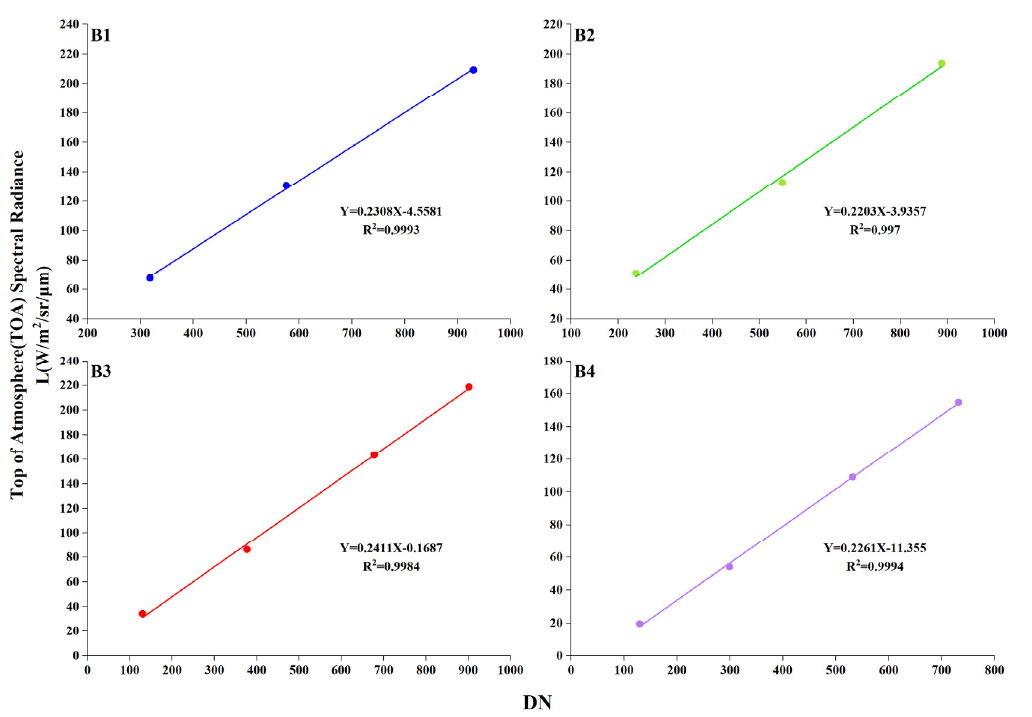
Figure 9. Calibration results using irradiance-based method on 28 June 2018.